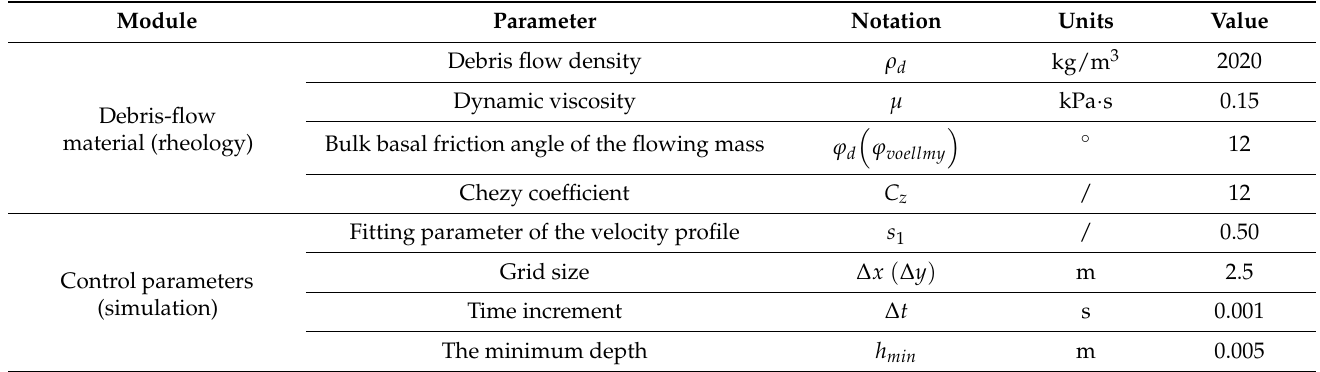
Table 2. Parameters used in the numerical simulation of the 2010 Hongchun debris flow event.